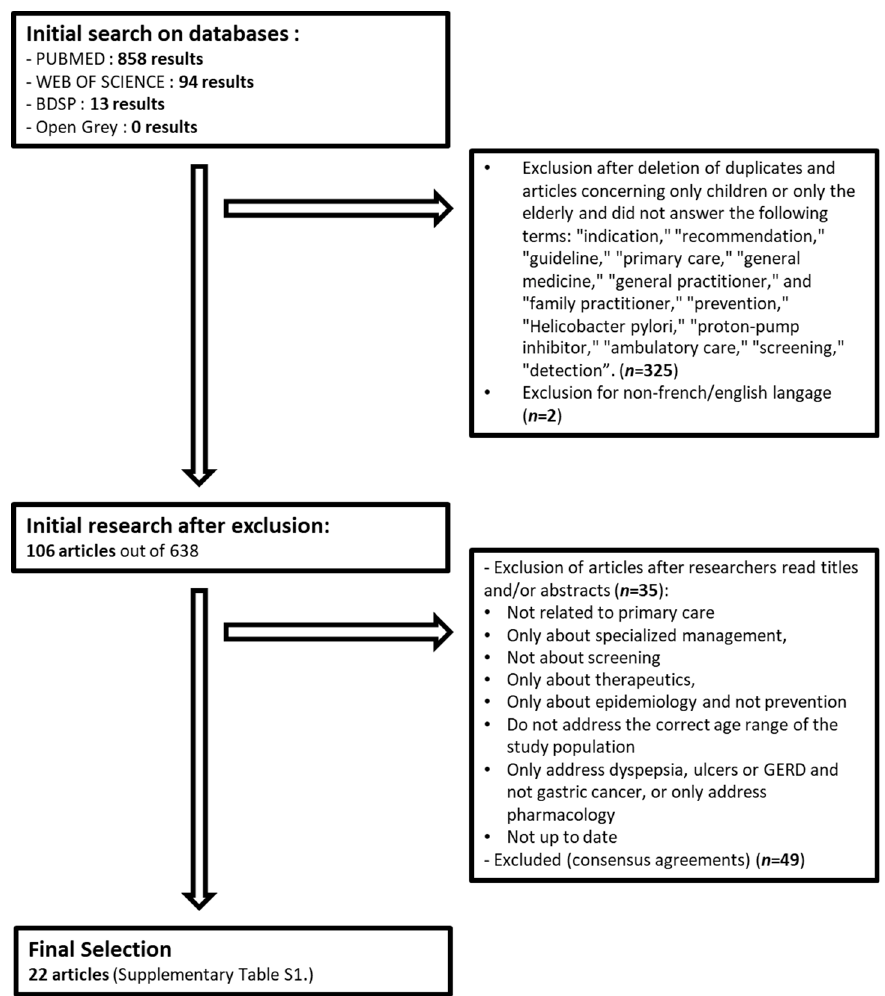
Figure 1. Flow chart for selection of analyzed articles.